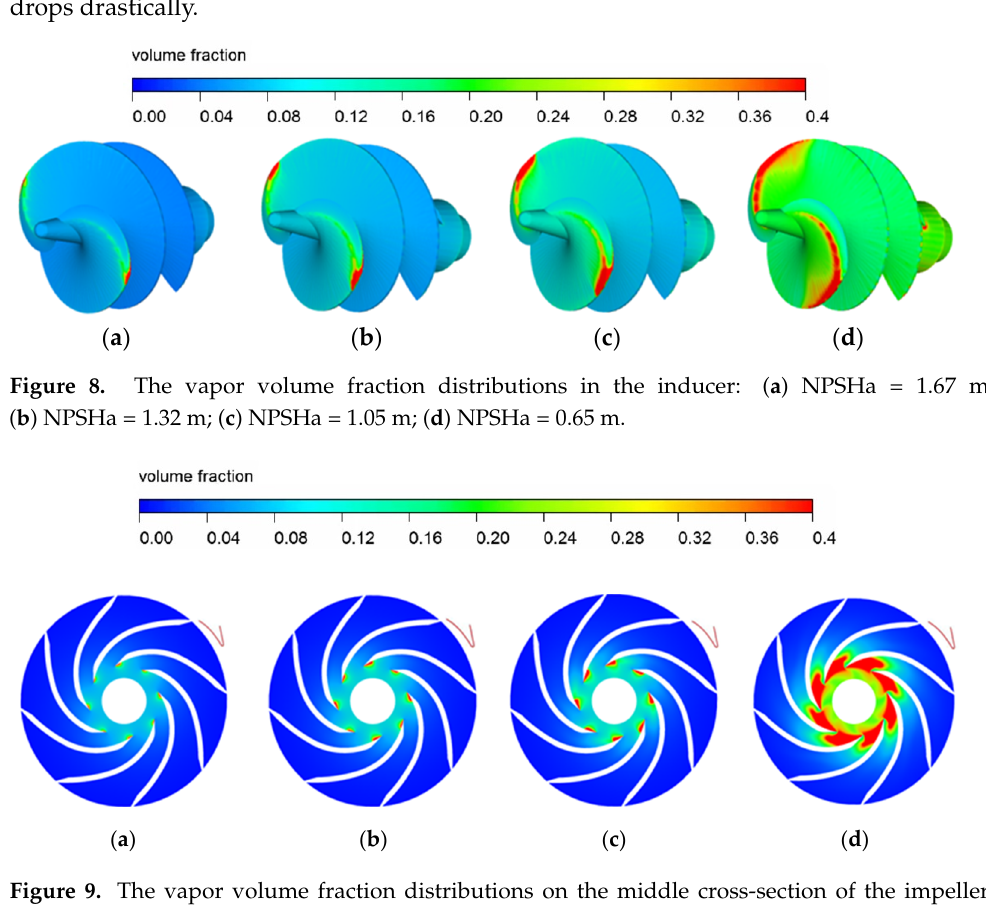
( d ) Figure 7. Static pressure distributions on middle cross-section of the impeller of the pump with inducer: ( a ) NPSHa = 1.67 m; ( b ) NPSHa = 1.32 m; ( c ) NPSHa = 1.05 m; ( d ) NPSHa = 0.65 m. The vapor volume fraction distributions in the inducer and impeller at design condi- tion are shown in Figures 8 and 9 when NPSHa is 1.67, 1.32, 1.05, and 0.65 m. From Figure 8, it can be seen that the bubbles in the inducer appear mainly in the lower pressure re- gions presented in Figure 8 when NPSHa is 1.67, 1.32, 1.05, and 0.65 m. These bubbles flowing along the spiral passage will tend to break for pressure increasing in the inducer. It is at the stage of cavitation incipience in the pump when NPSHa is 1.67 m, and the regions of larger vapor volume fraction in the inducer are relatively small. When NPSHa is 0.65 m, the vapor volume fraction in the inducer becomes larger, and the regions of